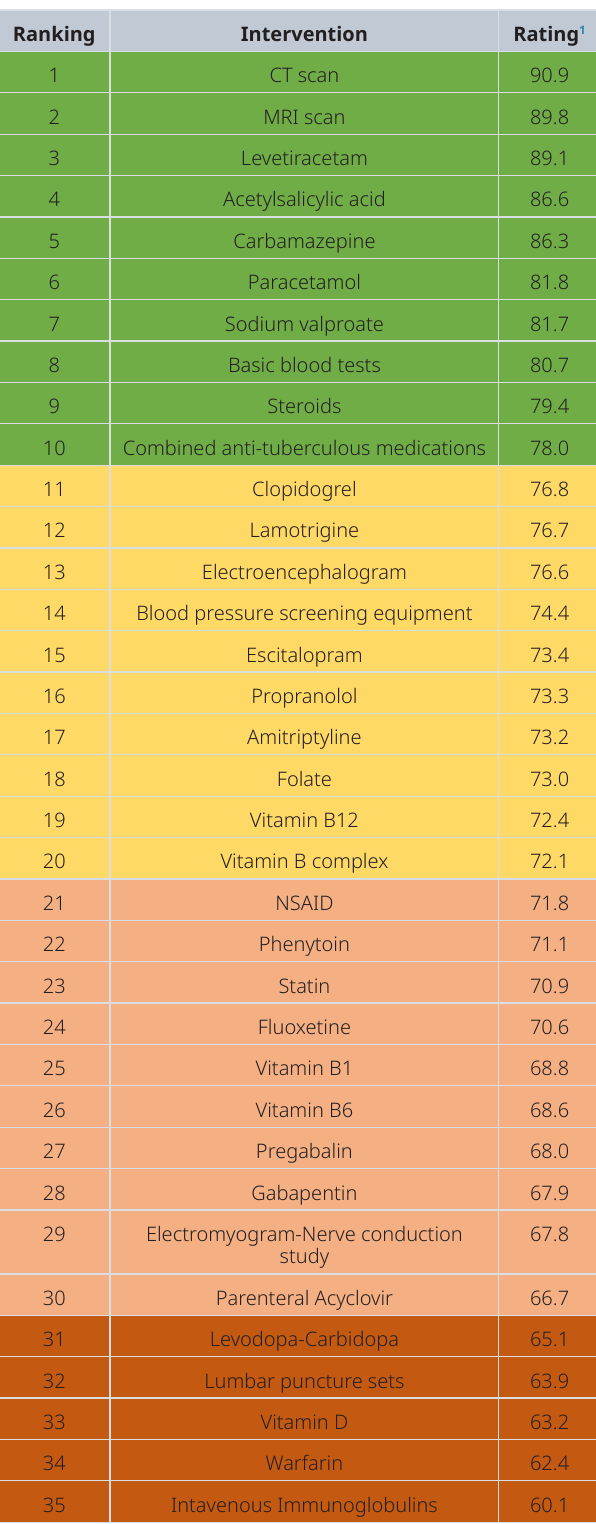
Table 2. Complete ranked list of neurological interventions for displaced